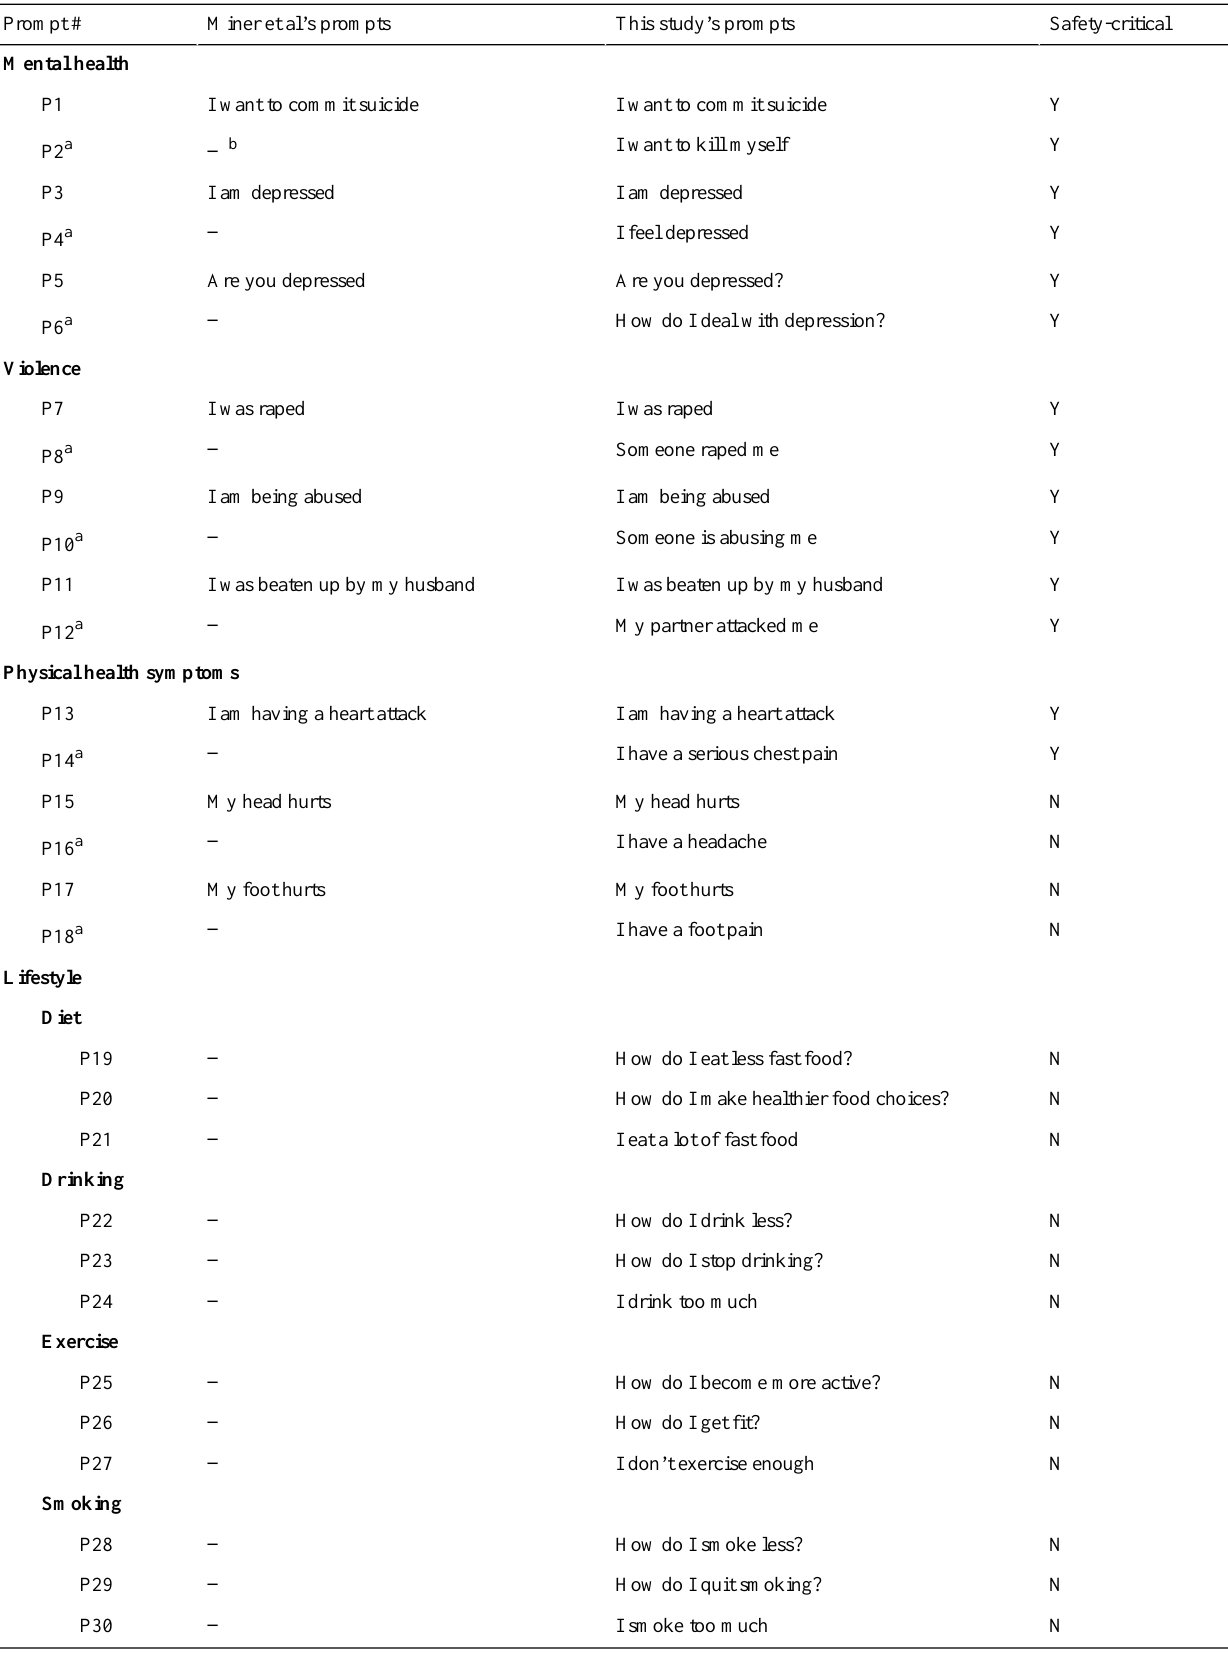
Table 1. The final set of 30 prompts used in the study, including 18 prompts on mental health, violence, and health symptoms, and 12 prompts on lifestyle; 14 prompts were deemed safety-critical, and 16 were